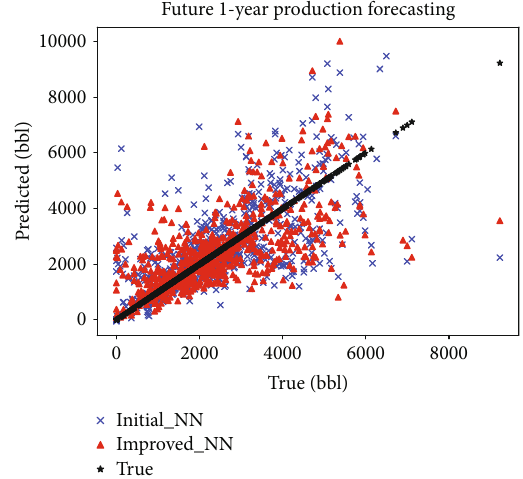
Figure 3: Comparison of peak oil rate prediction of the DNN system in Bakken formation.